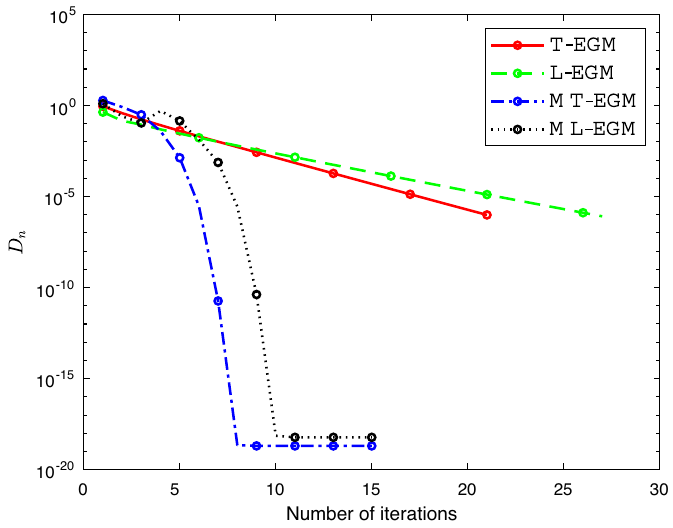
Figure 1: Numerical illustration of Algorithms 1 and 2 with Algorithm 1 in [ 28 ] and Algorithm 1 in [ 29 ] while N 10. =